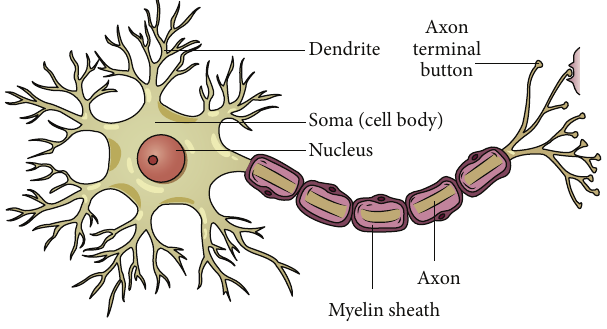
Figure 2: Structure illustration of